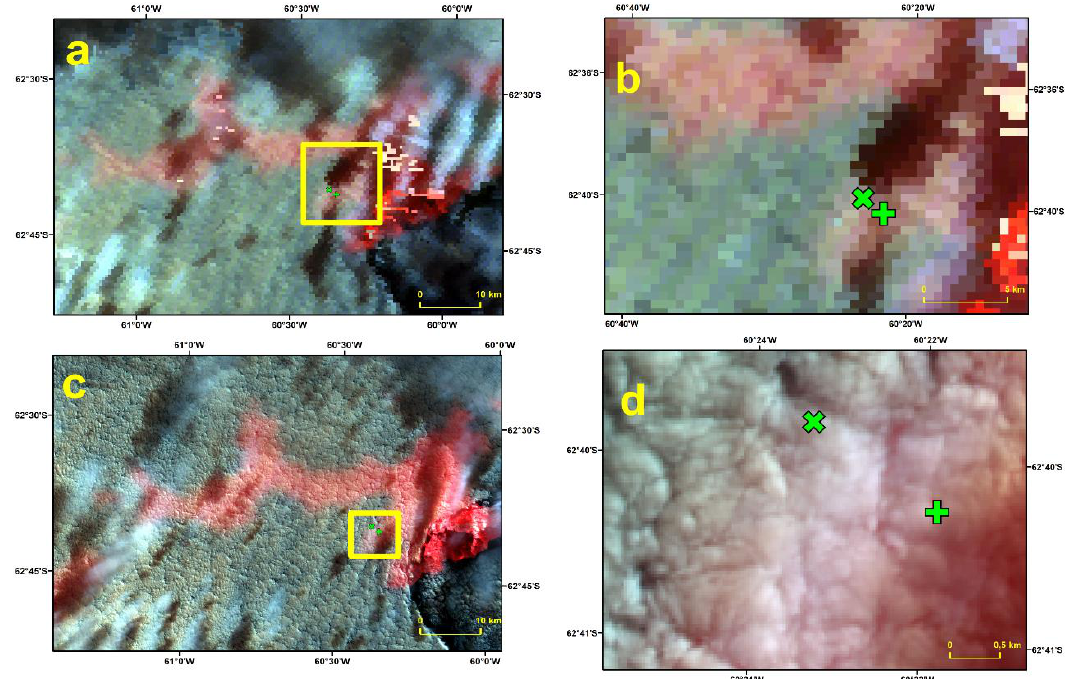
Figure 2. RGB composites of MOD09GA ( a ) and Landsat 8 ( c ) of Livingston Island of March 28 2014. The yellow box shows the area of the close view of the RGB composite of MOD09GA ( b ) and Landsat 8 ( d ) in the vicinity of the Automatic Weather Stations. The location of the Automatic Weather Stations at Juan Carlos I and Johnsons Glacier are indicated with a green cross and a green plus sign, respectively. Images provided in the WGS84 UTM20S projection.